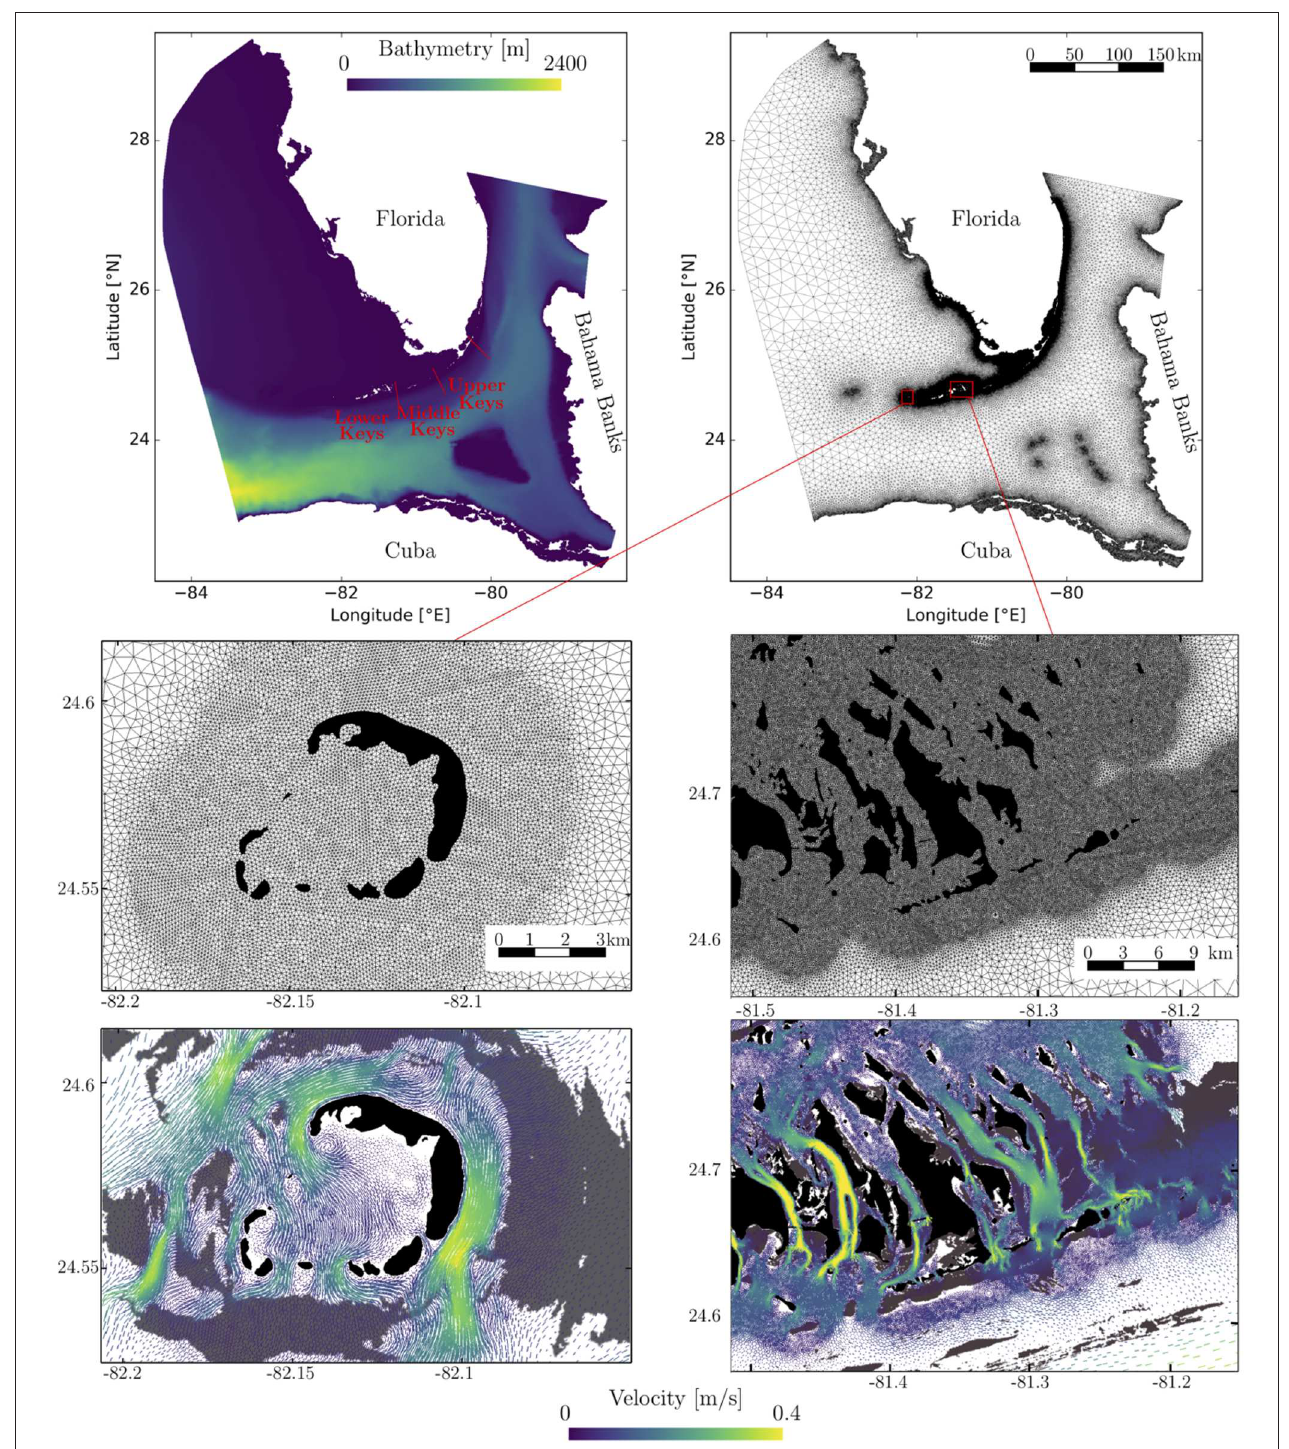
FIGURE 1 | (Top) Model computational domain with the bathymetry and location of the Lower, Middle, and Upper Keys (left), and the unstructured mesh (right). The mesh contains about 10 6 elements and the resolution varies between about 100 m and 15 km. Close-up views of the mesh (Middle) and snapshots of the currents on September, 27 2010 at 22:00 (Bottom) , for the Marquesas Keys (left) and the Lower Keys (right). This illustrates the benefits of unstructured meshes to represent the fine-scale details of the topography and hence simulate currents down to the scale of individual reefs (shown in gray) and islands (shown in black).